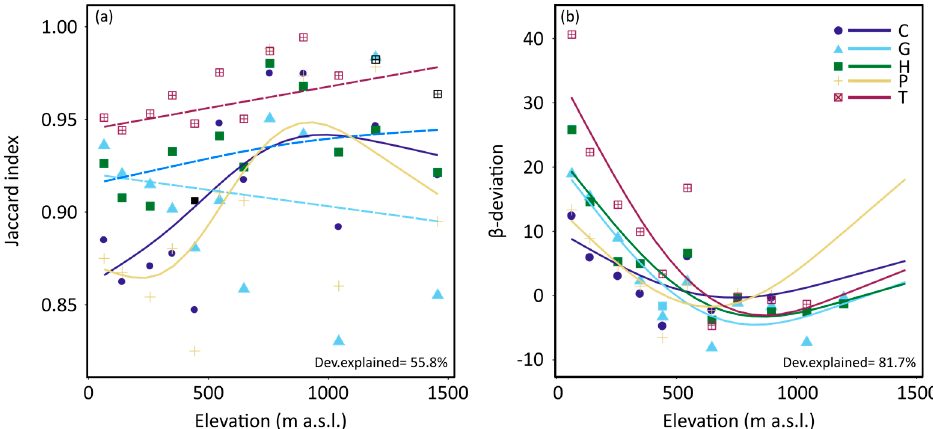
Figure 4. The relationship between elevation and Jaccard index of dissimilarity ( a ) and its deviation from random expectations ( b ) and deviance explained of the formulated Generalized Additive Models (summary statistics of the models are presented in Supplementary Material—Table S4) for different life forms across the formulated elevational zones. Points represent observed values and lines the predicted values by Generalized Additive Models predicting β -diversity and β -deviations as function of elevation (smooth term) by life form and life form. Significant relationships are indicated by solid lines. Life forms abbreviations: C = chamaephytes, G = geophytes, H = hemicryptophytes, P = phanerophytes, T = therophytes.